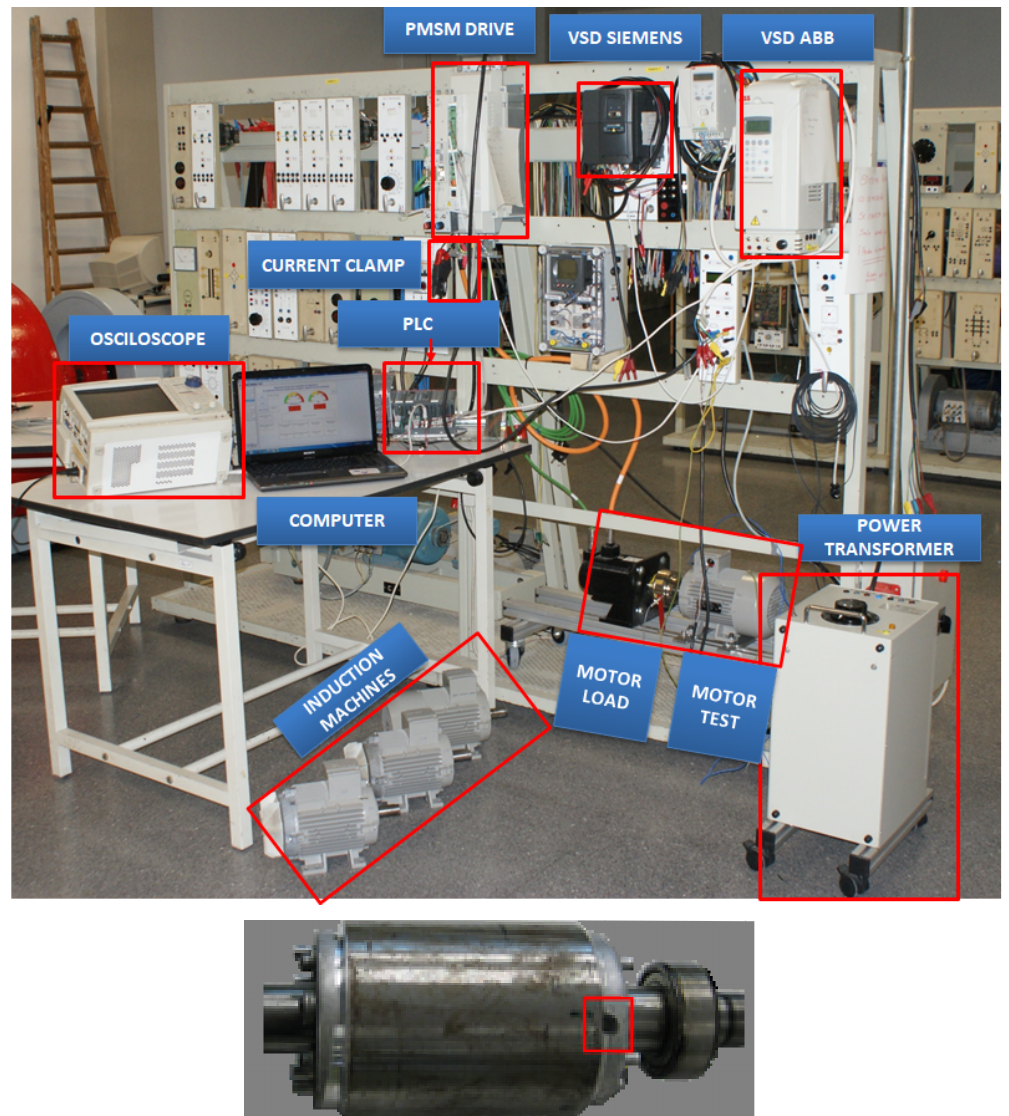
Figure 3. Top: test bench used for the experimental tests presented in this work. Bottom: detail of the rotor asymmetry provoked by drilling a hole in one of the rotor